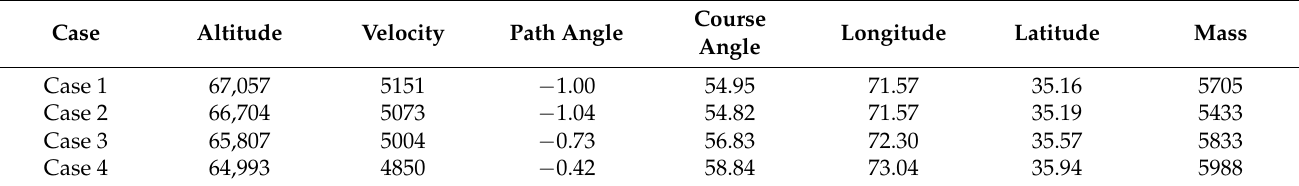
Table 8. Four cases in low energy